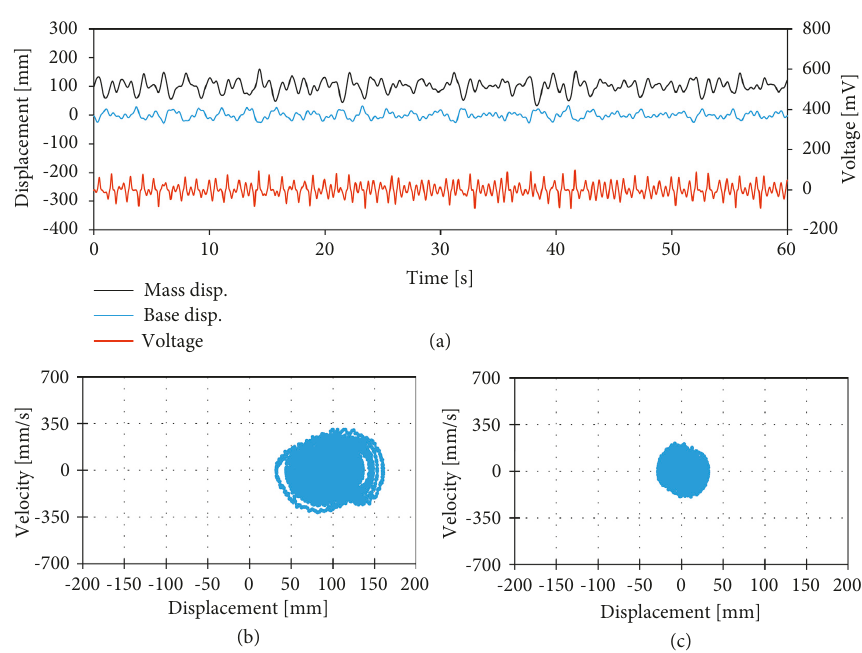
Figure 13: Measured results for vibration displacement and vibration power generation for vibration with a random signal and a periodic signal at 2.00 Hz. (a) Response vibration displacement results. (b) Diagram of displacement vs. velocity of vibration for the mass block. (c) Diagram of displacement vs. velocity of vibration for the support.